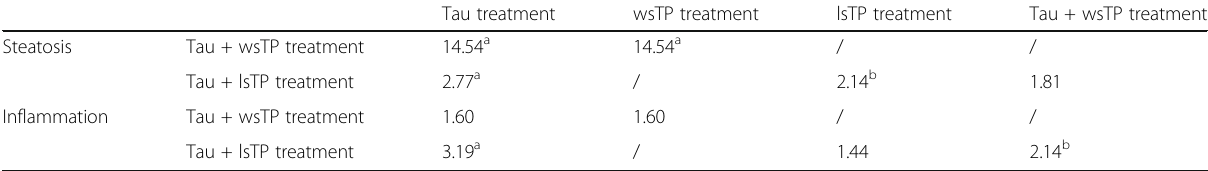
Table 4 Effect of combination or single treatment on histopathology (u value)